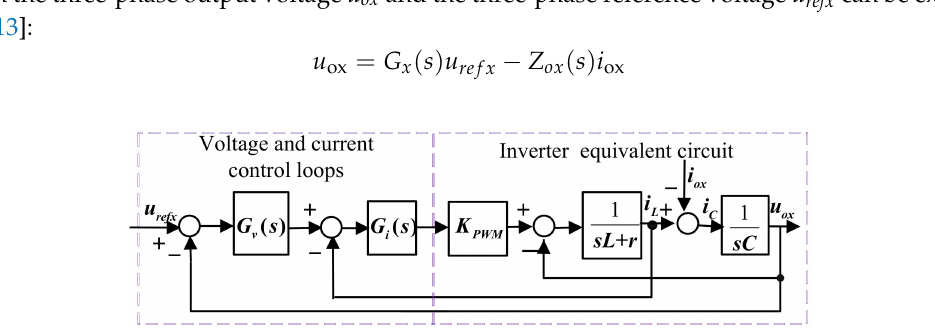
Figure 4. Block diagram of the voltage and current control